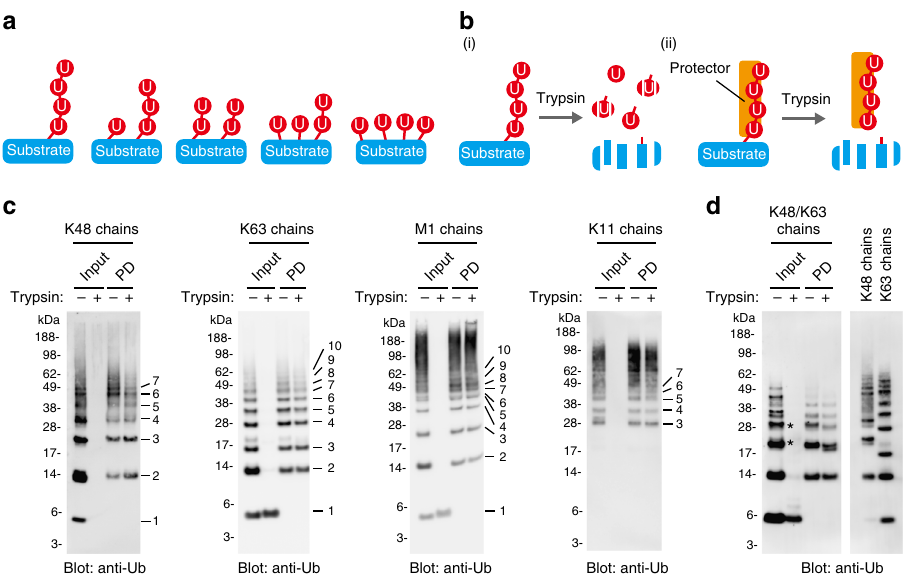
Fig. 1 Establishment of a method for determining ubiquitin chain length. a Different combinations of ubiquitylation with four ubiquitin molecules. Ubiquitins are depicted as red circles. This schematic does not take into account different linkage types or branching chains, which greatly increase the number of combinations. b Conceptual schematic of the “ ubiquitin chain protection from trypsinization (Ub-ProT) ” method. (i) Trypsinization under non-denaturing condition results in near-complete digestion of substrate proteins and partial digestion of ubiquitin chains, (ii) whereas a protector such as TR-TUBE protects ubiquitin chains from digestion. c Ub-ProT assay of free ubiquitin chains. K48-linked (left), K63-linked (center left), M1-linked (center right), and K11-linked (right) chains were pulled down with TR-TUBE (PD) and subjected to trypsinization. Ubiquitin was probed with anti-ubiquitin antibody. Positions of ubiquitin chains with different lengths are numbered. Monomeric Ub is more resistant to trypsinization compared to Ub chains, and sometimes remains after trypsinization of input samples (lane 2 in the middle two gels). d Ub-ProT assay of K48/K63 branched chains. K48/K63 branched chains were captured by TR-TUBE, subjected to trypsinization, and detected using anti-ubiquitin antibody. Positions of ubiquitin chains with different lengths are numbered. Asterisks denote branched ubiquitin chains (Supplementary Fig.